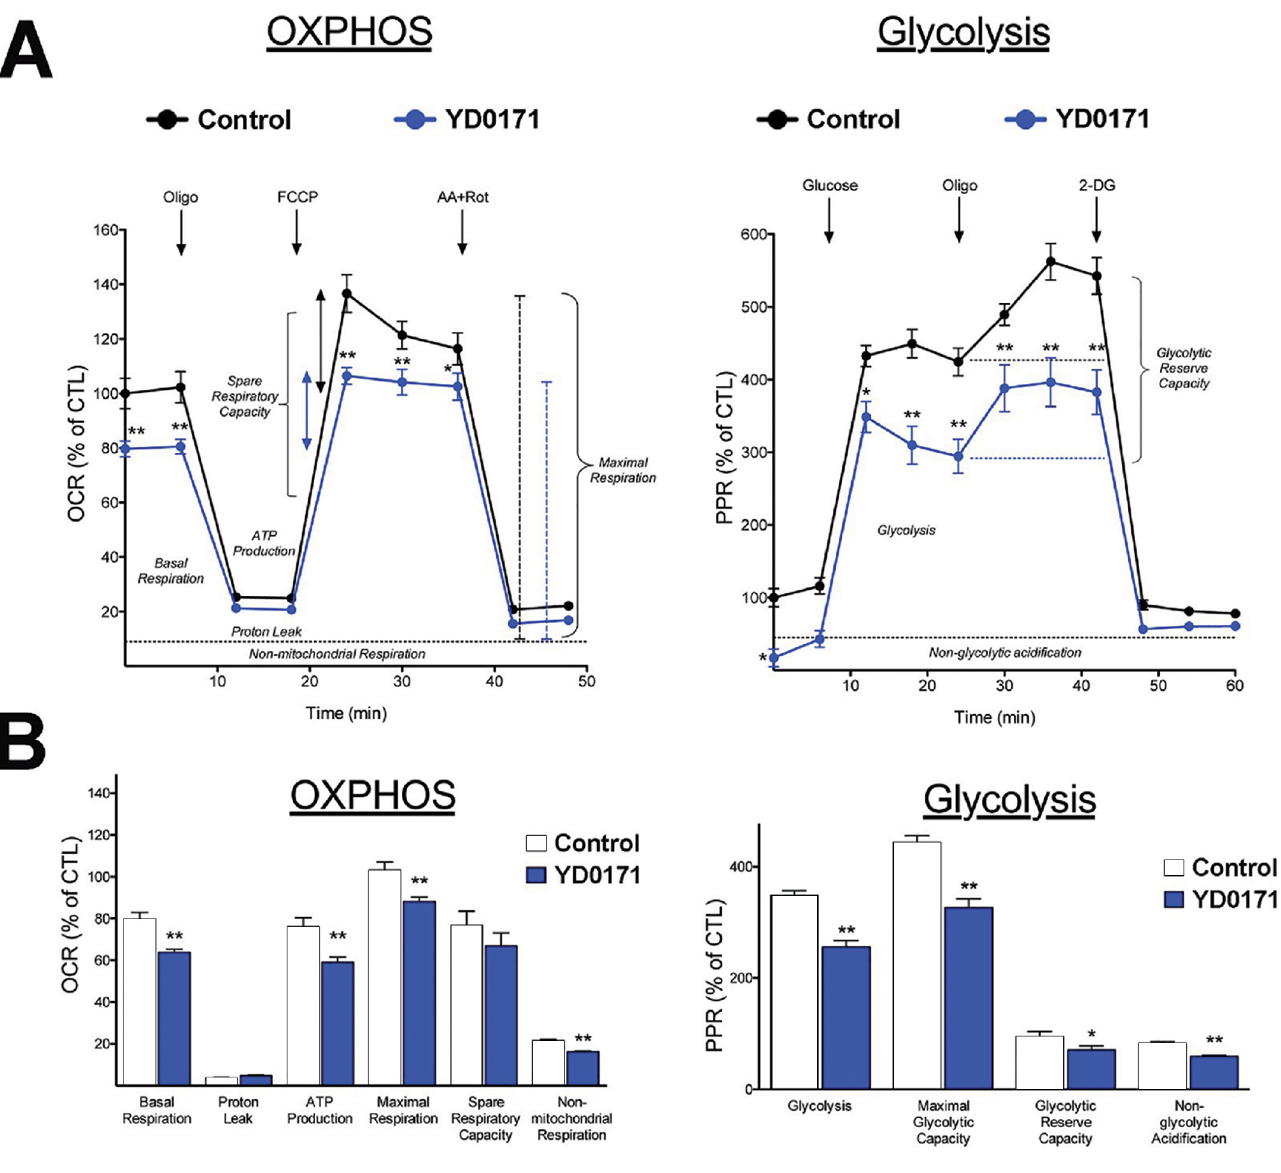
Figure 9. Inhibition of cellular bioenergetic parameters by YD0171 in HCT116 cells. Cells were treated with YD0171 (1 mmol/L) for 24 h, followed by extracellular flux analysis. (A) Left panel: mitochondrial function analysis. Four key parameters of mitochondrial function (basal respiration, ATP turnover, proton leak and maximal respiration) were assessed through the sequential use of 40 μ mol/L oligomycin (ATP synthase inhibitor), 13.5 μ mol/L FCCP (mitochondrial uncoupler) and 10 μ mol/L rotenone + 1 μ mol/L antimycin A (complex I and III inhibitors). The difference between the maximal and the basal respirations was considered the re- spiratory reserve capacity (the capacity of a cell to generate ATP via oxidative phosphorylation in response to increased demand for energy). Right panel: analysis of glycolytic function. A glycolytic stress test was used to estimate various parameters of cellular glycolysis (glycolysis, glycolytic capacity and glycolytic reserve), which was obtained with the sequential use of 25 mmol/L glucose, 5 μ mol/L oligomycin (to block mitochondrial respiration and force the cells to rely on glycolysis for ATP production) and 100 mmol/L 2-deoxyglucose (2-DG, a glucose analog and inhibitor of glycolytic ATP production). Glycolytic reserve was calculated as the dif- ference between the glycolytic capacity and glycolysis; this parameter is indicative of the cellular ability to increase the glycolytic rate upon increased energy demand. Acidification of carbon dioxide, the end product of the TCA cycle, which can be converted to bicarbonate, is considered a major contributor to nonglycolytic acidification. (B) Statistical analysis of the various bioenergetic parameters. Data shown as mean ± SEM; n = 6; * p < 0.05 and ** p < 0.01 indicate significant inhibitory effects of YD0171 on the various bioenergetic parameters, compared with vehicle